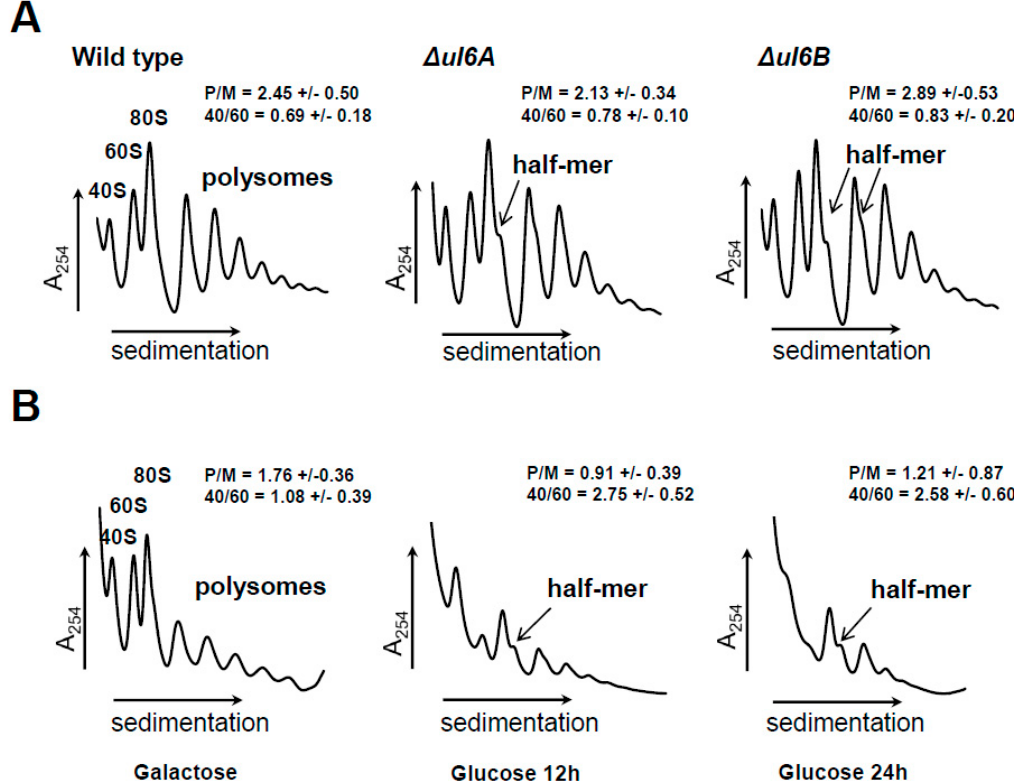
Figure 4. Polysome profile analysis of uL6 mutants. Polysome profile of ( A ) single uL6A or uL6B deletion mutants and wild type strain grown on YPD; ( B ) double uL6A and uL6B mutant grown on YPD for 12 h and 24 h after the shift from the YPGal medium. The sedimentation vector of the ribosomal fractions is indicated by a horizontal arrow, and optical density analysis at 254 nm is shown on the Y -axis; the positions of individual ribosomal subunits and half-mers are indicated.